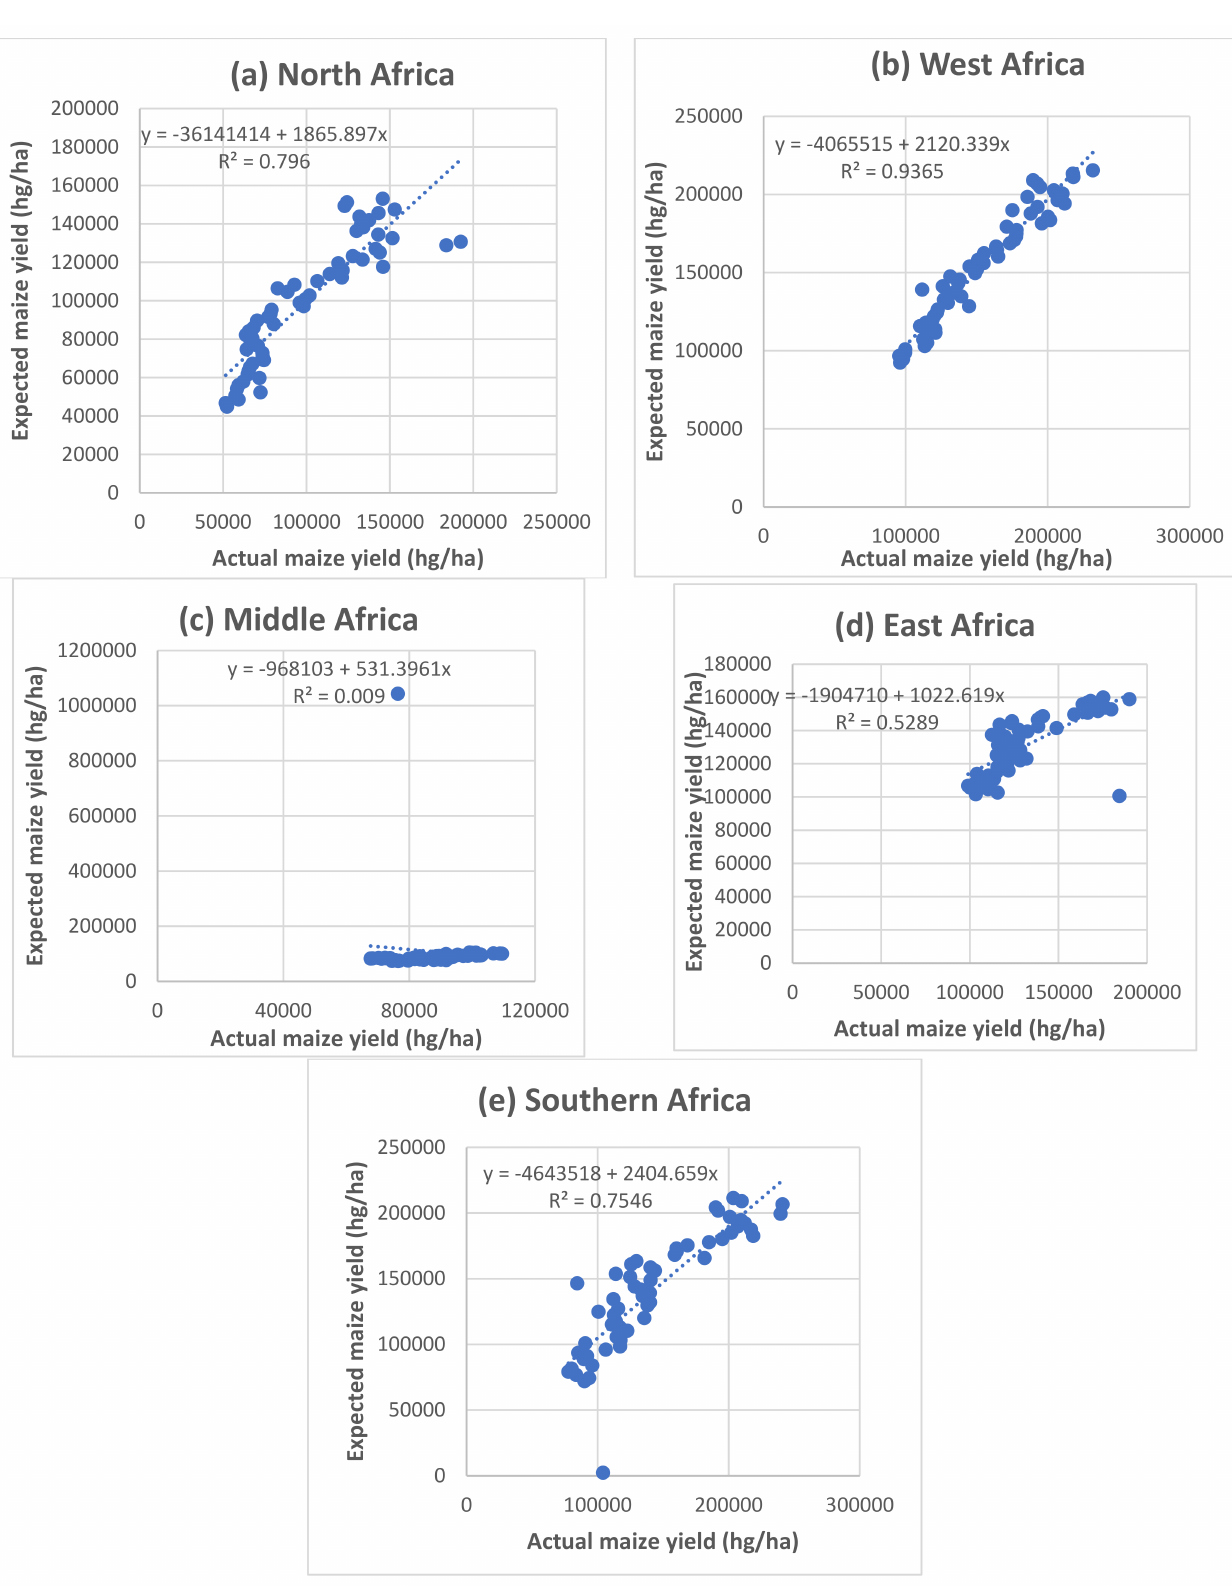
Figure 10. Scatter plots of actual and expected maize yield in ( a ) North Africa, ( b ), West Africa ( c ), Middle Africa, ( d ) East Africa, & ( e ) Southern